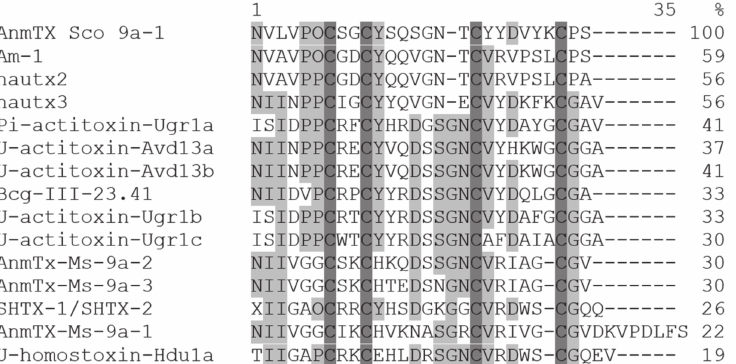
Figure 3. Multiple sequence alignment of the structural group 9a toxins: AnmTX Sco 9a-1 (C0HM64) S. coccinea ; Am-1 (P69929) from Antheopsis maculata [31]; hautx2 (A0A0P0UTI6) and hautx3 (A0A0P0UTQ7) from Heteractis aurora [32]; Pi-actitoxin-Ugr1a, U-actitoxin-Ugr1b, and U-actitoxin- Ugr1c (R4ZCU1) from Urticina grebelnyi [22]; U-actitoxin-Avd13a and U-actitoxin-Avd13b (P0DMZ8) from Anemonia viridis [33]; Bcg-III-23.41 (P86467) from Bunodosoma cangicum [34]; AnmTx-Ms-9a-1, AnmTx-Ms-9a-2 (A0A1R3S3A8), and AnmTx-Ms-9a-3 from Metridium senile [23]; SHTX-1/SHTX-2 (P0C7W7) from Stichodactyla haddoni [35]; and U-homostoxin-Hdu1a (C0HJB4) from Stichodactyla duerdeni [36]. Modified residue–hydroxyproline shown as O in sequences. Identical and conserved amino acid residues are shown on a dark and light gray background, respectively. Vector NTI Advance v. 11.0 (Invitrogen, Carlsbad, CA, USA) [37] was used for multiple sequence